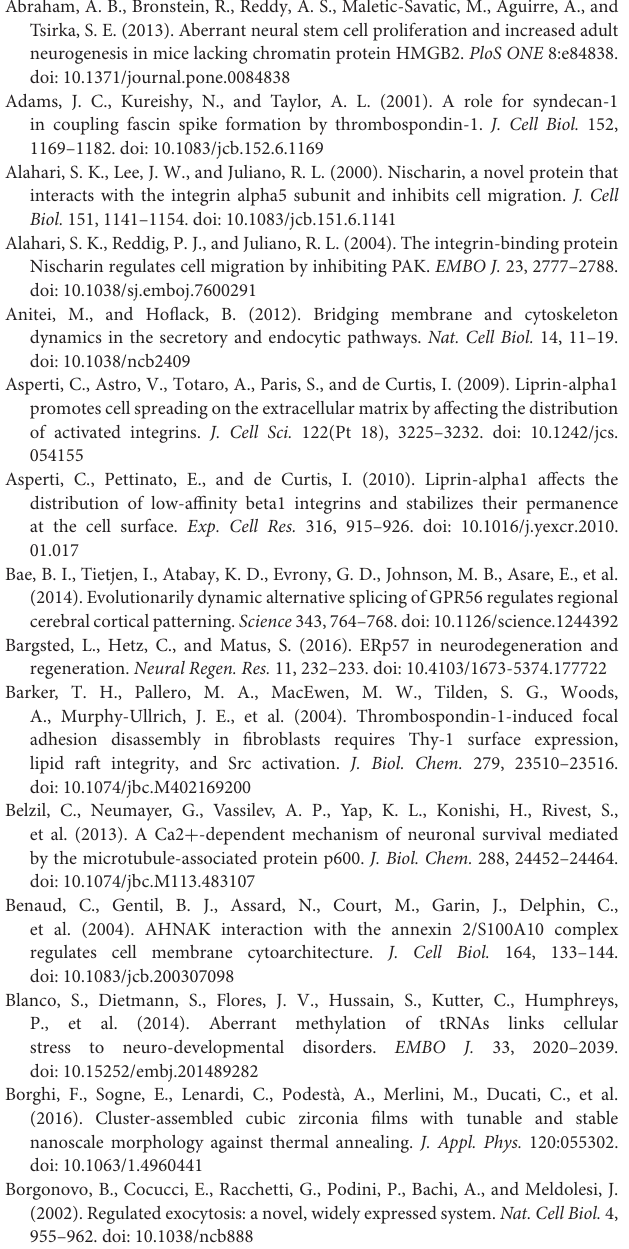
Table S25 | Proteins differently expressed comparing PLL hyper vs PLL. List of the proteins annotated with Perseus software. Categorical annotation was supplied in form of Gene Ontology (GO) biological process (BP), molecular function (MF), cellular component (CC), keywords as well as in participation in a KEGG pathway and molecular complexes (CORUM). x = proteins with a similar alteration of the expression level comparing ns-Zr15 vs flat-Zr and PLL hyper vs PLL; X = proteins altered in an opposite manner in ns-Zr15 vs flat-Zr and PLL hyper vs